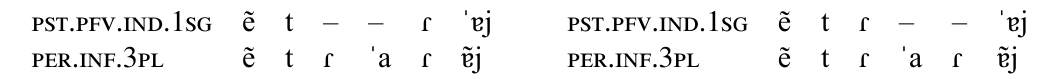
Table 6: Two alignments of the PST.PFV.IND.1SG and PER.INF.3PL forms of ENTRAR ‘enter’ with identical